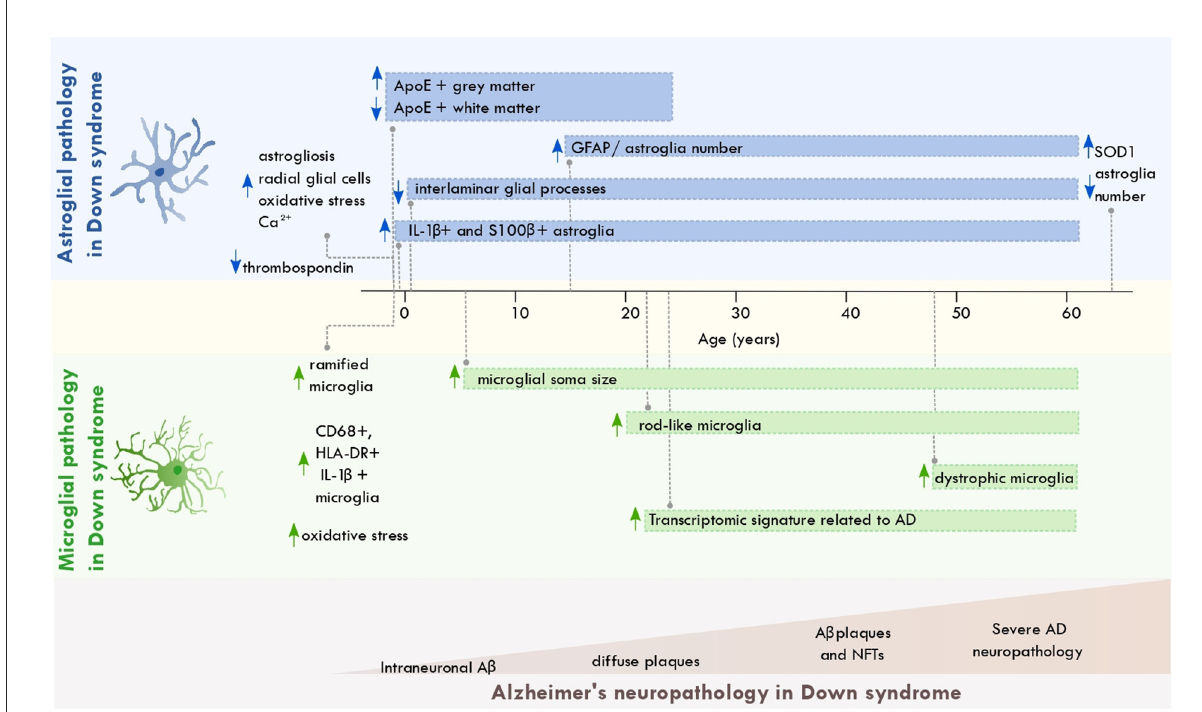
FIGURE1 Astroglial and microglial pathology across the lifespan of individuals with Down syndrome. Scheme depicting the most significant changes in astrocytes and microglia from individuals with Down syndrome across aging and along with the progression of AD neuropathology. The brain regions where these disruptions occur are described in the main text. A β , amyloid beta; NFT, neurofibrillary tangles; ApoE, apolipoprotein E; AD, Alzheimer’s disease; SOD, superoxide dismutase 1; GFAP, glial fibrillary acidic